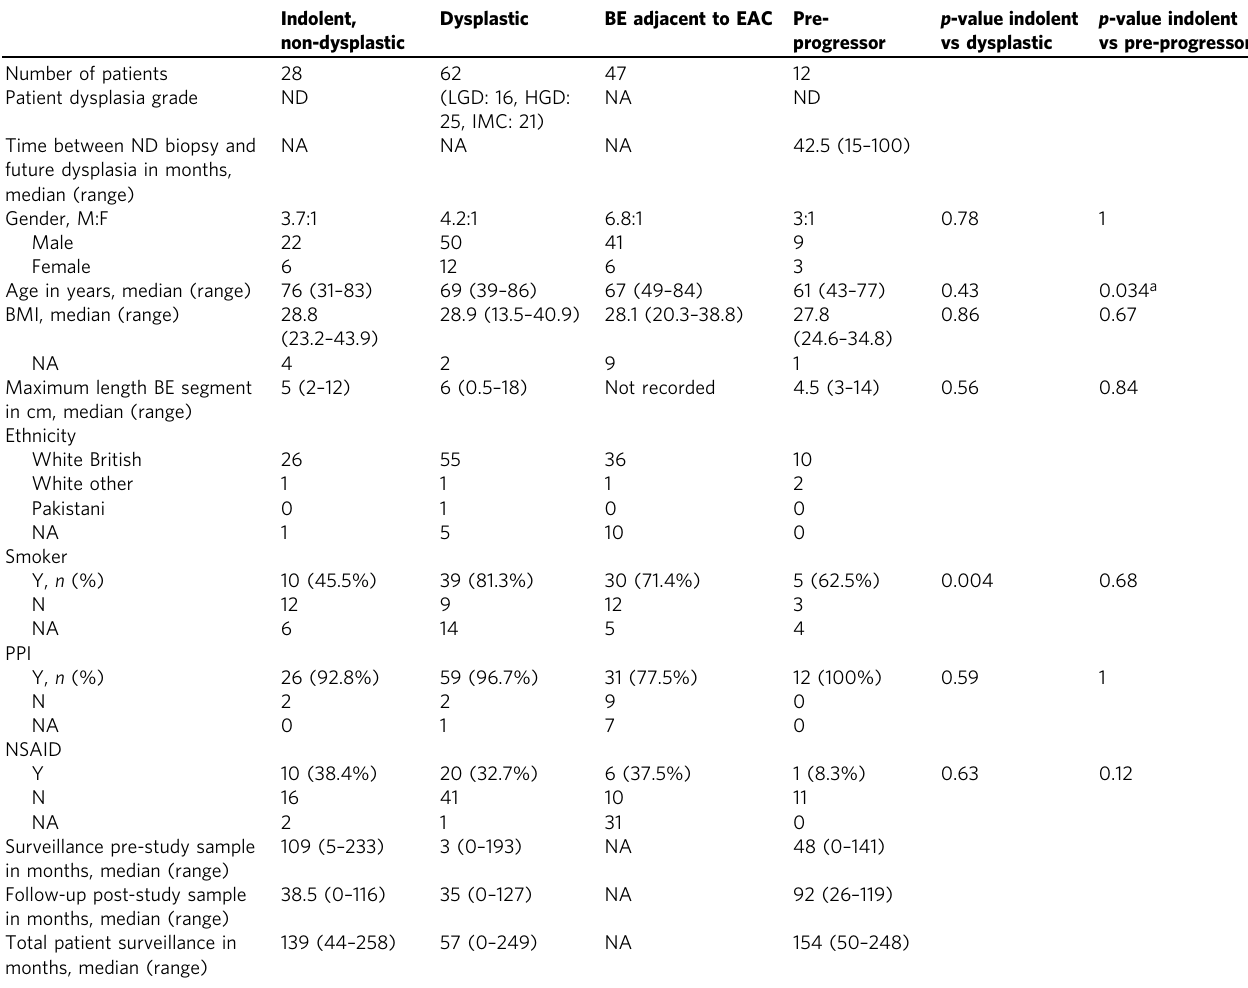
Table 1 Cohort demographics and clinical